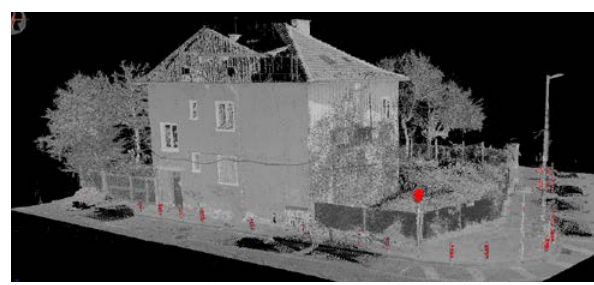
Figure 22: Building in a parcel 68134.902.248 – point cloud Control measurements were also made of the point cloud.